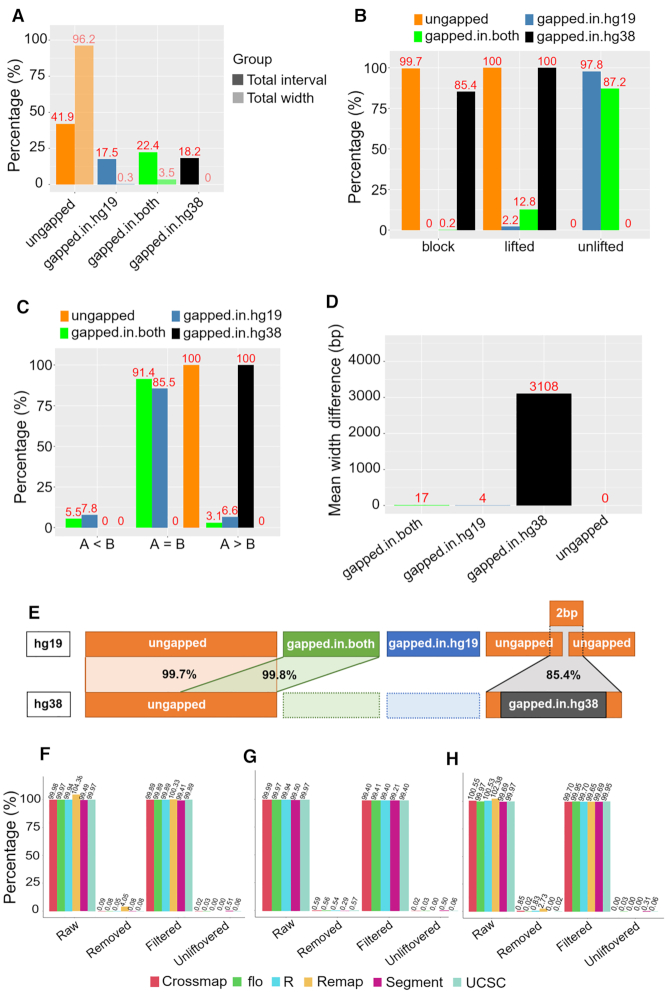
Benchmarking six liftover tools from hg19 to hg38. (A) Percentage of the number of intervals and length of ungapped, gapped-in-hg19, gapped-in-both and gapped-in-hg38 on the hg19 assembly. (B) Percentage of lifted, unlifted and lifted to the corresponding block by regions. (C) Comparing the length of intervals before and after conversion by regions. (D) Mean of width difference by regions. (E) Summary of the underlying principle of liftover for each region. (F) Liftover 250 000 CpGs using six tools. (G) Liftover all CpGs using five tools (exclude NCBI remap). (H) Liftover a ChIP-Seq sample using six tools.